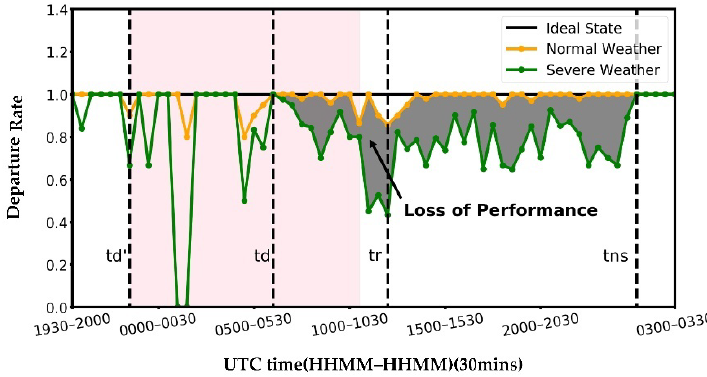
Figure 4. Airport flight operation resilience performance under SD.